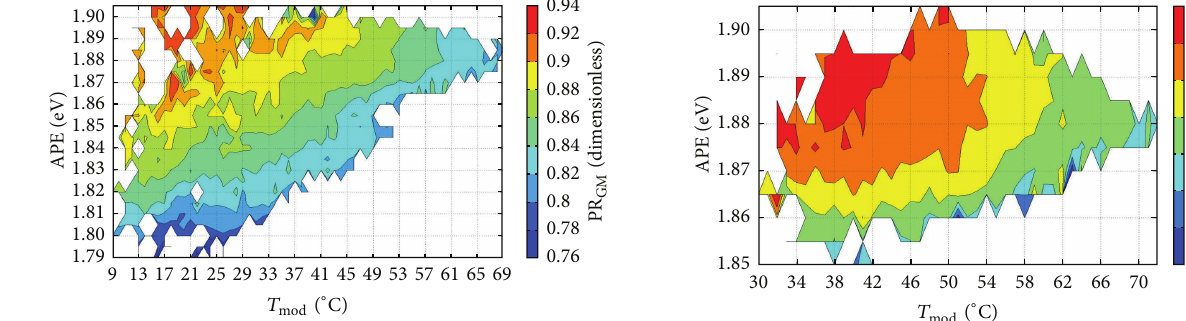
Figure 8: Contour graph of PR of the tested a-Si:H PV module as a function of 𝑇 mod and APE for the summer period. Blank areas indicate no data